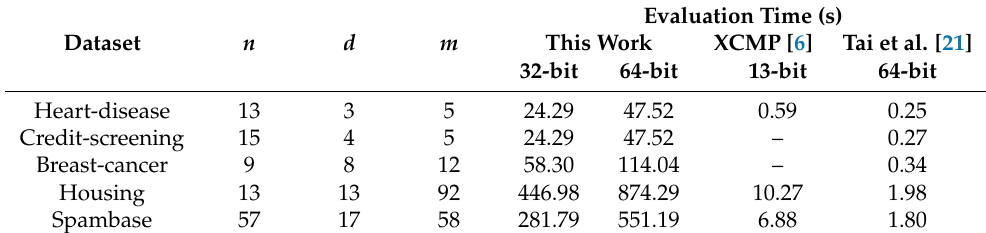
Table 2. Performance of secure evaluation on real datasets from UCI